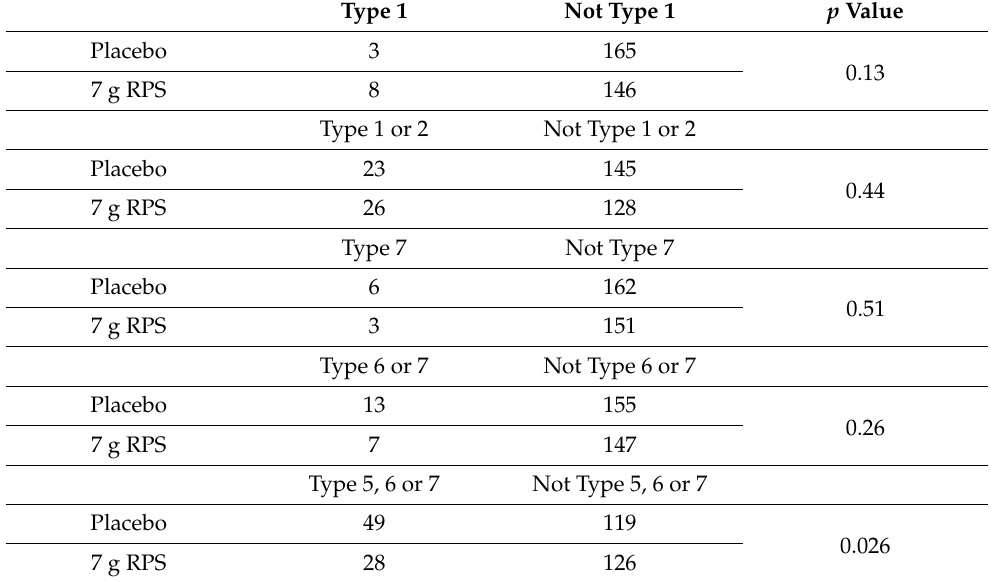
Table 5. Presence of bowel movements scored according to the Bristol Stool Chart (BSC) at 4 weeks in the 7 g RPS and placebo